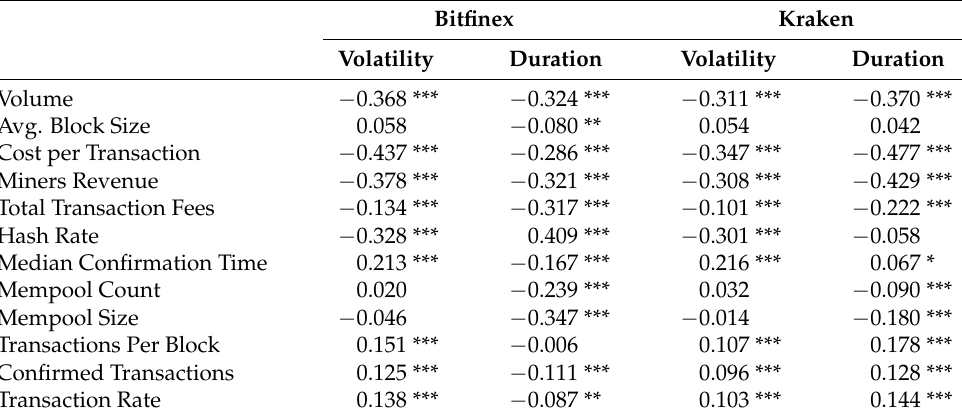
Table 2. Correlation of duration and blockchain